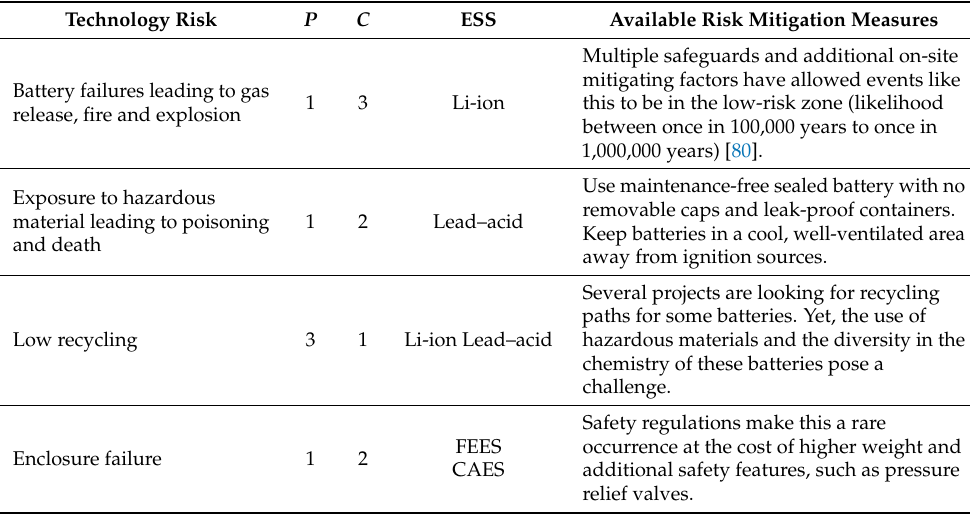
Table 6. High-level risk assessment for implementation of technologies in Scenario